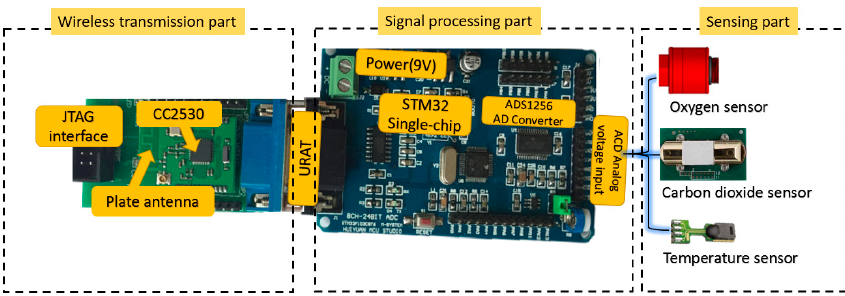
( b ) Figure 4. Modeling procedure of GM-PSO-LSSVM forecasting with error rectification. 2.4. Wireless Sensing System 2.4.1. Ambient Sensing Hardware Transportation process of live flatfish with oxygen forecasting was performed by an ambient sensing device that mounted in the transporting boxes. It consists of three parts: (1) The sensing part of the ambient factors in the closed fresh-keeping system, which harvests the spot ambient information. (2) The signal processing part that preprocesses the obtained data during the processing of real-time monitoring. (3) Packaging of the ambient sensing data back to the gateway for intelligent training and on-line forecasting by the GM-PSO-LSSVM. The monitoring equipment is shown in Figure 5, and has three parts: the ZigBee module (CC2530) for wireless communication, the front signal processing module (STM32F, analog to digital converter) and micro ambient sensors (SHT11, AO2, MH-Z14). The sensors are connected to the analog to digital converter by the interface ADC (Analog-to-Digital Converter) and the ADC to the microchip STM32